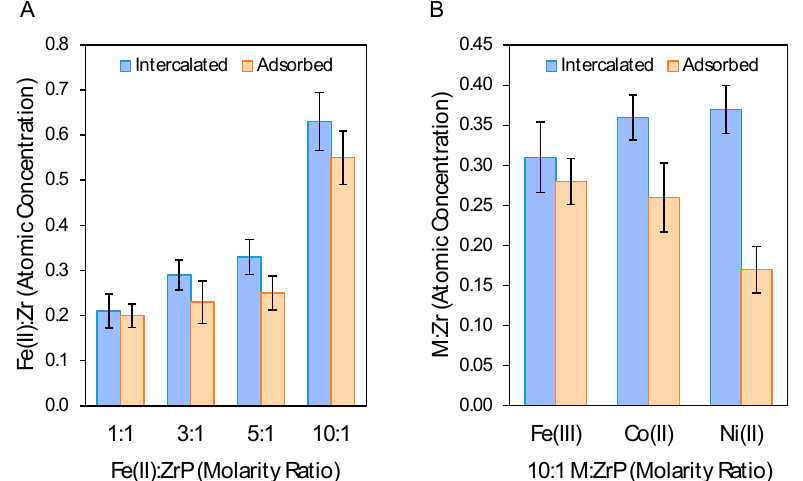
Figure 5. ( A ) Atomic concentration Fe:Zr ratios for metal-modified 1:1–10:1 Fe(II):ZrP molar ratio catalysts. ( B ) Atomic concentration M:Zr ratios for Fe(III), Co(II), and Ni(II) metal-modified 10:1 M:ZrP molar ratio catalysts.